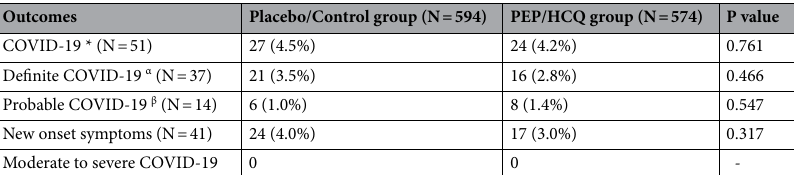
Table 2. Incidence of COVID-19 after post exposure prophylaxis with HCQ and placebo. *The participant with either definite or probable COVID-19 was defined as COVID-19 case. Total absolute risk reduction was -0.3% points and number needed to treat (NNT) was 333.3 with relative risk of 0.91 (95% confidence interval, 0.52 to 1.60). α The participant with RTPCR positive for SARS-CoV-2 and with or without symptoms was defined as definite COVID-19 case. Total absolute risk reduction was -0.7% points and the NNT was 143 with relative risk of 0.78 (95% confidence interval, 0.40 to 1.51). β The participant with new onset COVID-19 related symptoms but RTPCR negative for SARS-CoV-2 or could not be performed for any reason was defined as probable COVID-19 case.